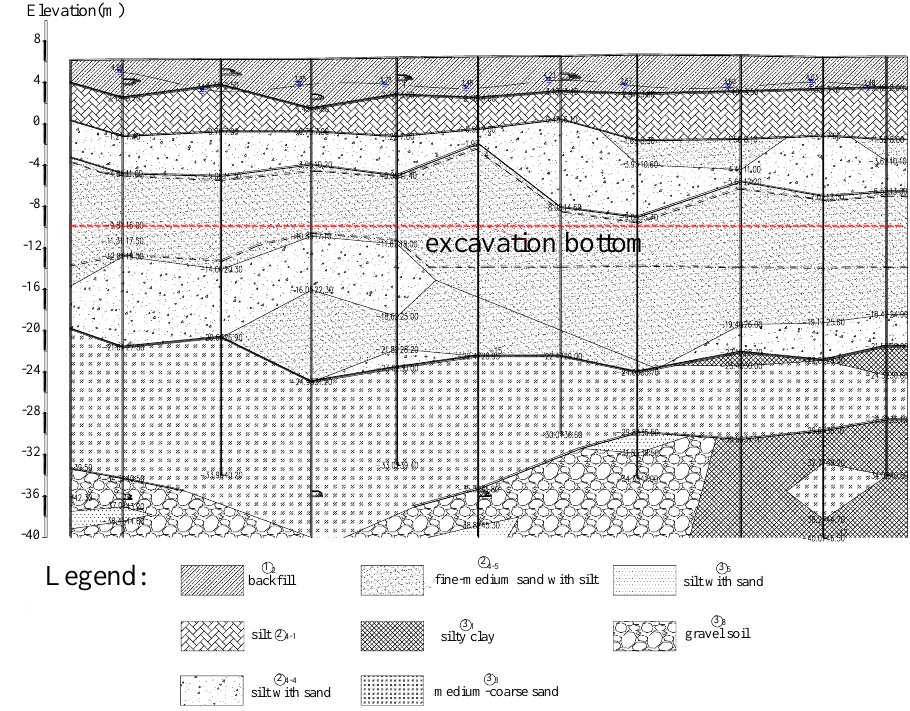
Figure 7. Typical geology profile at site.